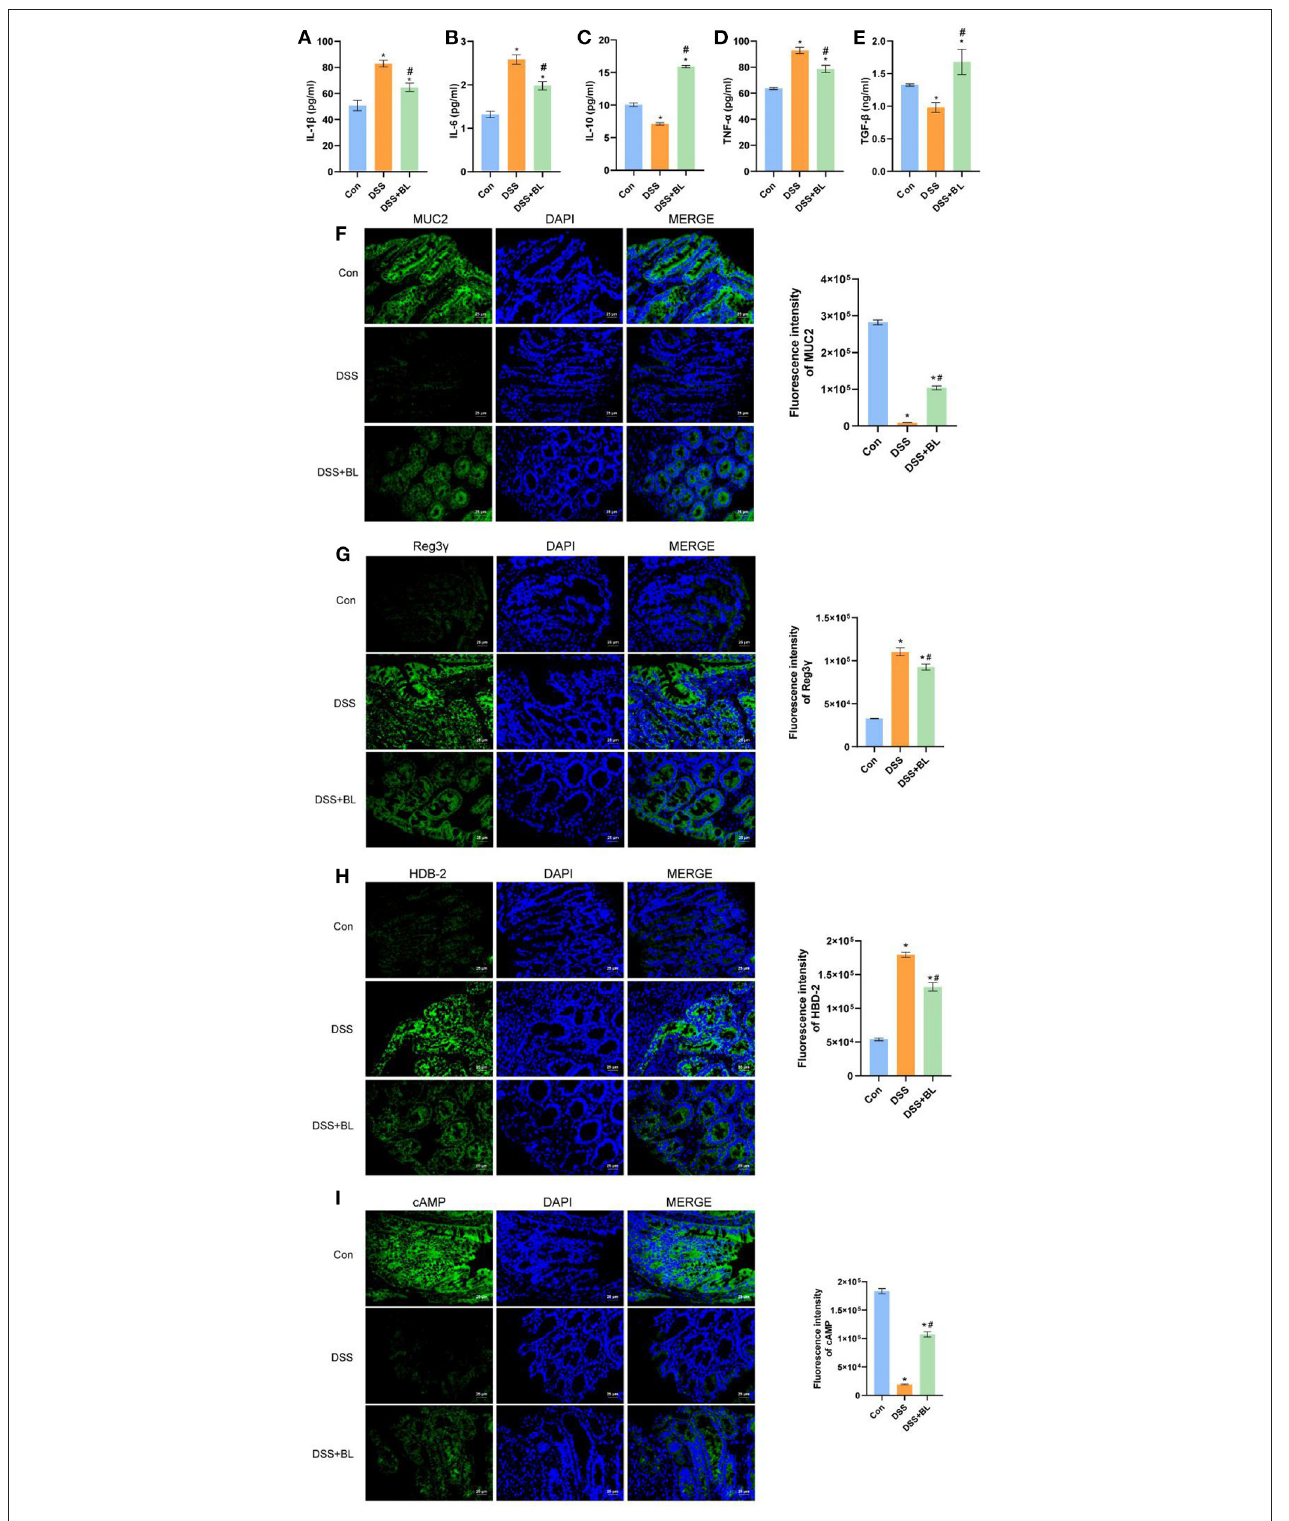
FIGURE 3 | Effects of bovine lactoferrin (BL) on inflammatory factors and expression of colonic mucosa-related defense proteins in dextran sulfate sodium salt (DSS) mice. (A–E) ELISA of inflammatory factors, IL-1 β , IL-6, IL-10, TGF- α , and TNF- β of colon tissue in mice. (F) Immunofluorescence results and analysis of MUC2. (G) Immunofluorescence results and analysis of Reg3 γ . (H) Immunofluorescence results and analysis of HBD-2. (I) Immunofluorescence results and analysis of cAMP. One-way ANOVA was used to compare the three groups. * P < 0.05 vs. control; # P < 0.05 vs. DSS.